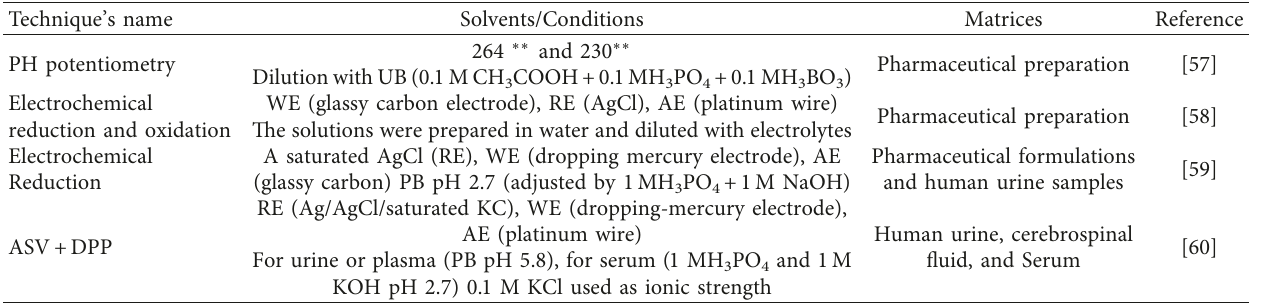
Table 3: Potentiometric and electrochemical methods for assay of